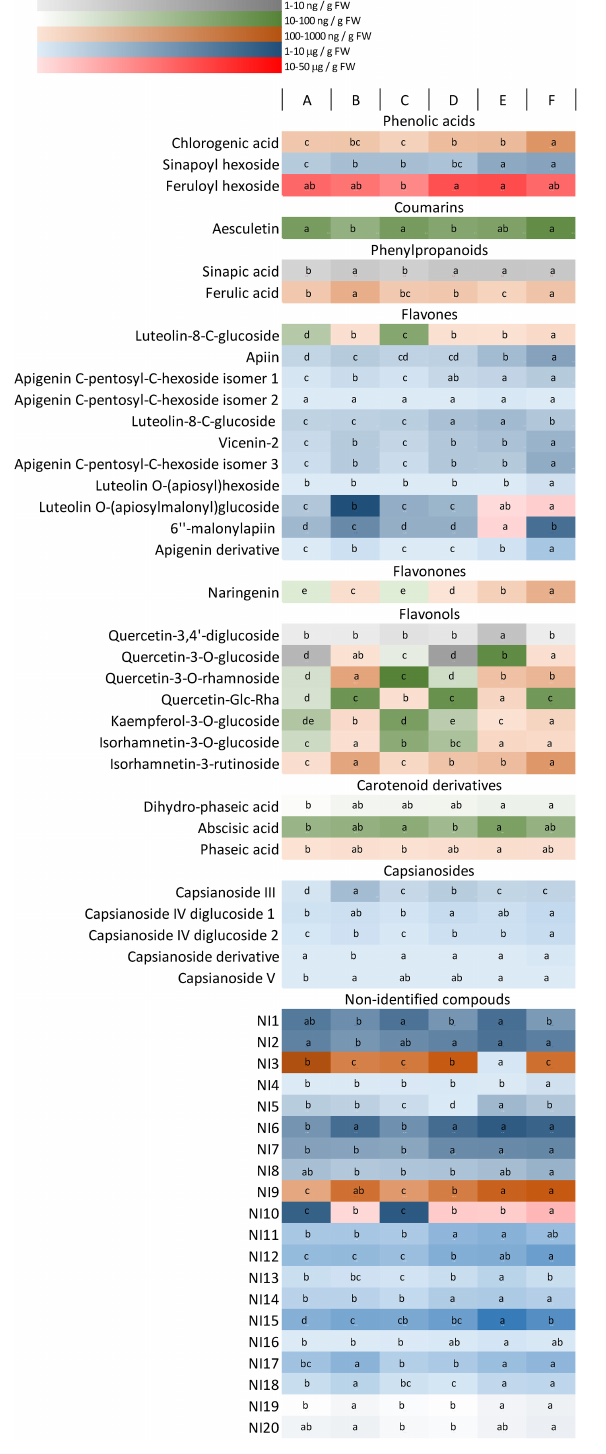
FIGURE 3 | Tukey’ s post-hoc test. Light conditions used: (A) application of red and blue LEDs with a 95:5 ratio at moderate (300 µ mol m − 2 s − 1 ) light intensity; (B) utilisation of red and blue LEDs with an 80:20 ratio at (300 µ mol m − 2 s − 1 ) light intensity; (C) a wide spectrum with an average proportion of 65:20:15 of red:green:blue at moderate (300 µ mol m − 2 s − 1 ) light intensity: (D) a wide spectrum supplemented with far-red application in an average proportion of 65:20:15:0.6 of red:green:blue:far-red at moderate (300 µ mol m − 2 s − 1 ) light intensity; (E) a wide spectrum supplemented with far-red application in an average proportion of 65:20:15:0.6 of red:green:blue:far-red at high (500 µ mol m − 2 s − 1 ) light intensity; (F) a wide spectrum